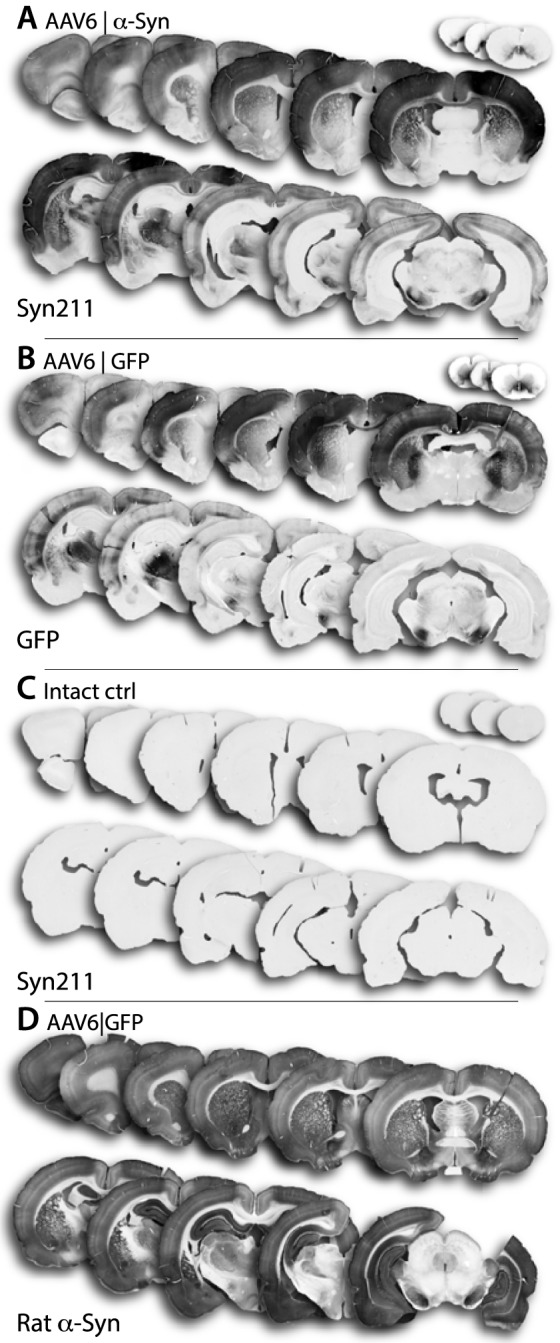
Histological overview of transduced brain regions.At 40 weeks post AAV injection, the long-term group was sacrificed and coronal brain sections stained with antibodies recognizing the respective transgene, syn211 against human α-Synuclein and a chicken polyclonal antibody against GFP. Intact control animals (Intact ctrl) were stained with both antibodies to confirm specificity (only syn211 shown). Transduction pattern was very similar in both the AAV6|a-Syn and the AAV6|GFP group with a very intense immunoreactivity in the cerebral cortex (A,B). Very low staining was observed in the Intact ctrl animals with the syn211 antibody (C), confirming the specificity of this antibody towards human α-synuclein. The expression pattern of human α-Syn (A) differed substantially from the expression pattern of endogenous rat α-synuclein as observer through staining with another antibody recognizing also the rat α-synuclein (BD Biosciences 610786) (D). For clarity, sections from the spinal cord are not to scale with the brain sections and have been enlarged to 200%.